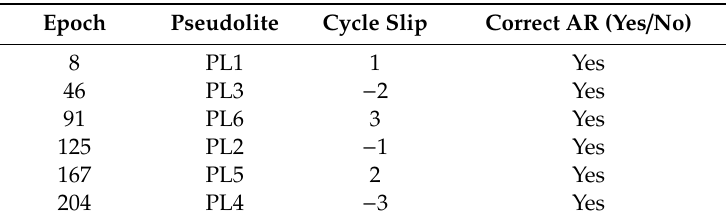
Table 7. AR performance with artificial cycle slips.